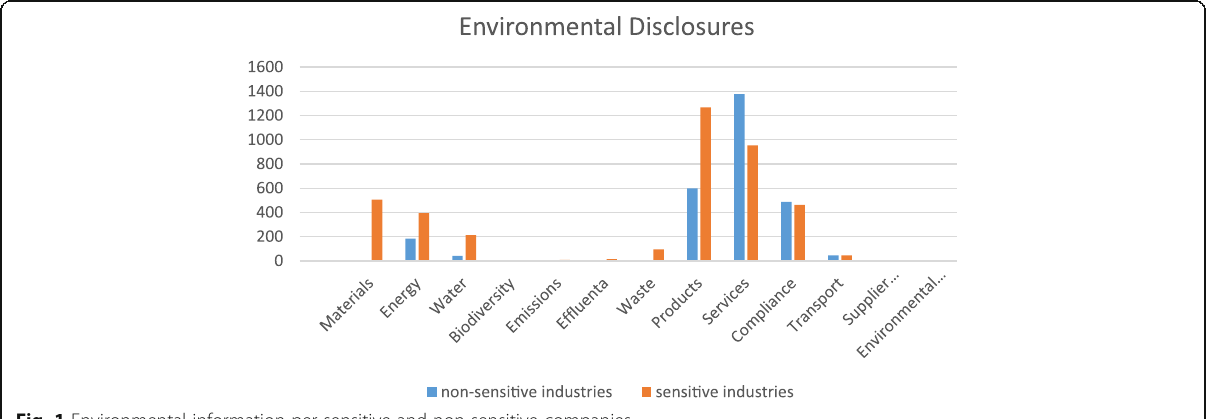
Fig. 1 Environmental information per sensitive and non-sensitive